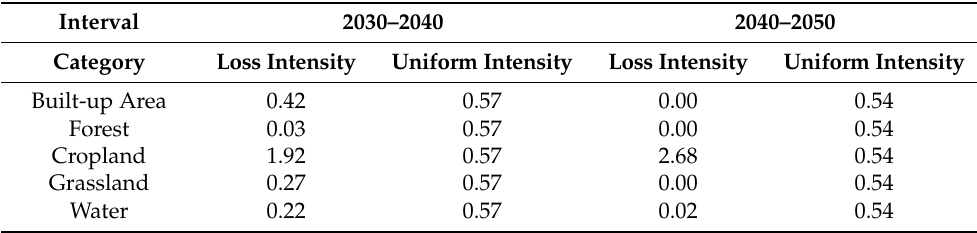
Table 26. Category-level Loss